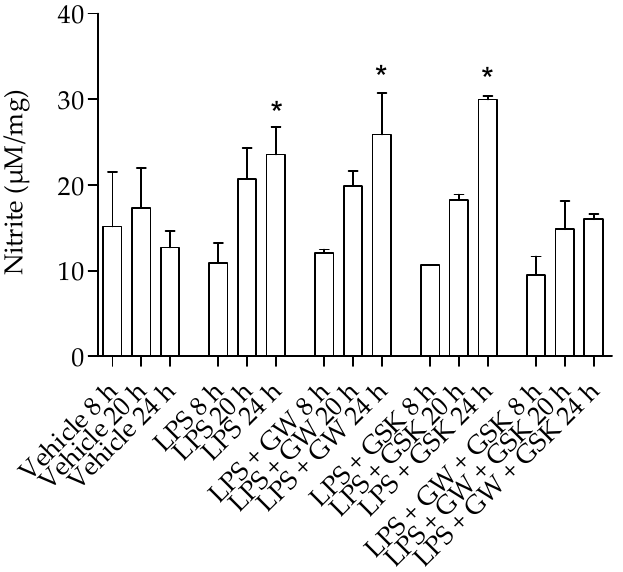
Figure A1. Nitrite (a marker for NO release) production by pulmonary artery over time. Rat pulmonary artery rings were treated with different combinations of 1 µ g/mL LPS (to induce innate inflammation), 100 nM GW0742 (PPAR β / δ agonist), 1 µ M GSK3787(PPAR β / δ antagonist), and the NO production was measured at 8 h, 20 h and 24 h of incubation (n = 3). The data are presented as mean ± standard deviation; the data was not normally distributed (D’Agostino–Pearson normality test). Significant difference by the Krustal-Wallis test with Dunns post hoc test is indicated by * = p < 0.05 compared with vehicle of same time point.